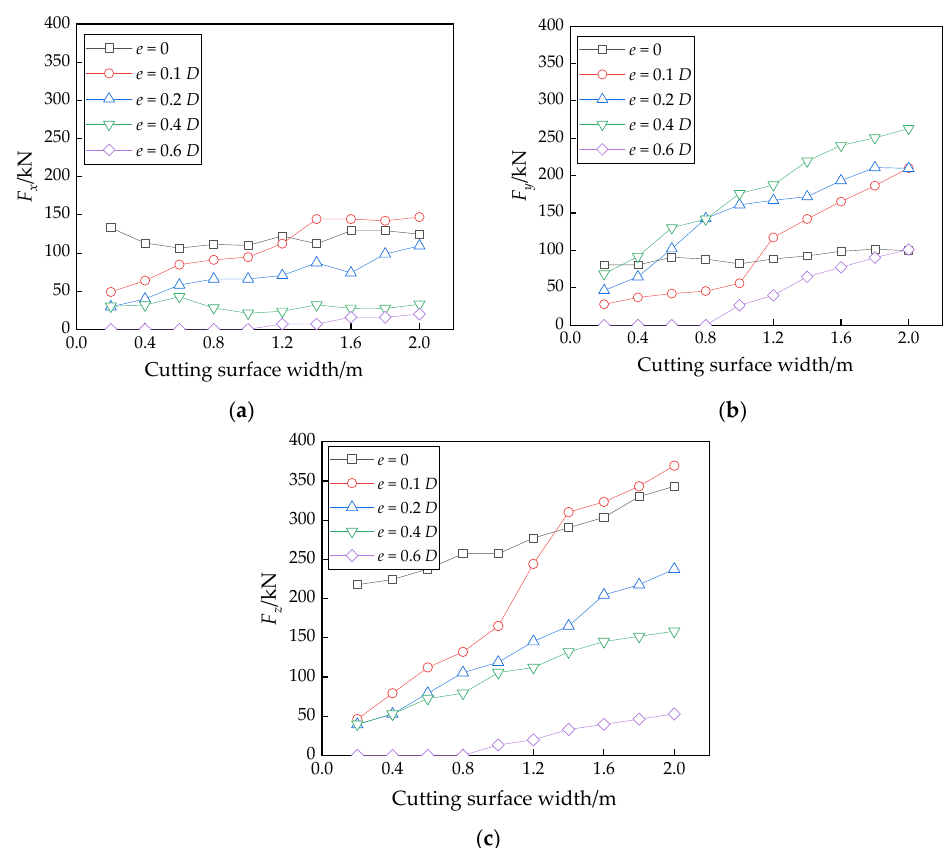
the Y direction were added to each other and penetrate forces in the Z direction have the same signs as well.